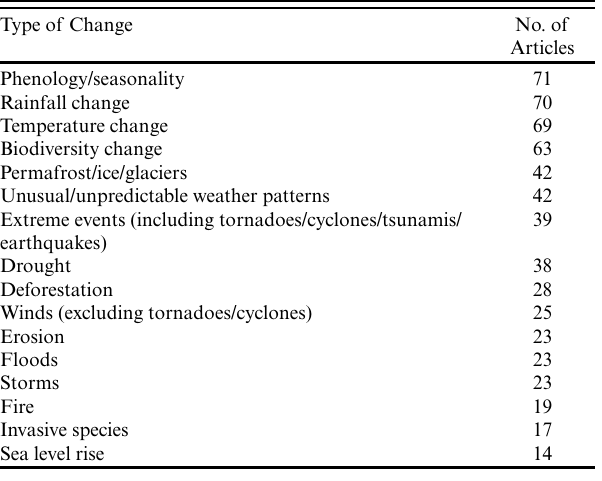
Table 3 . Types of locally perceived global environmental change reported in articles